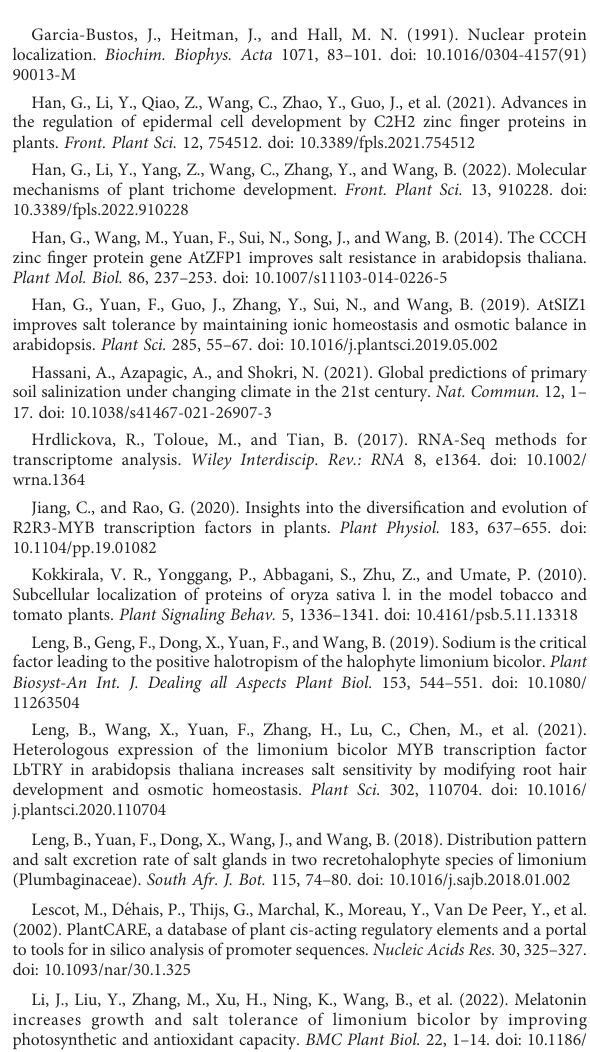
SUPPLEMENTARY FIGURE 2 The relative expression lvels of LbMYB48 gene in TRV ::LbMYB48 and TRV :: 0 lines. Three replicates should be set up to calculate the standard deviation (SD) and ensure accuracy. Different letters (a – b) were used to indicate signi fi cant differences between different columns at P < 0.05.